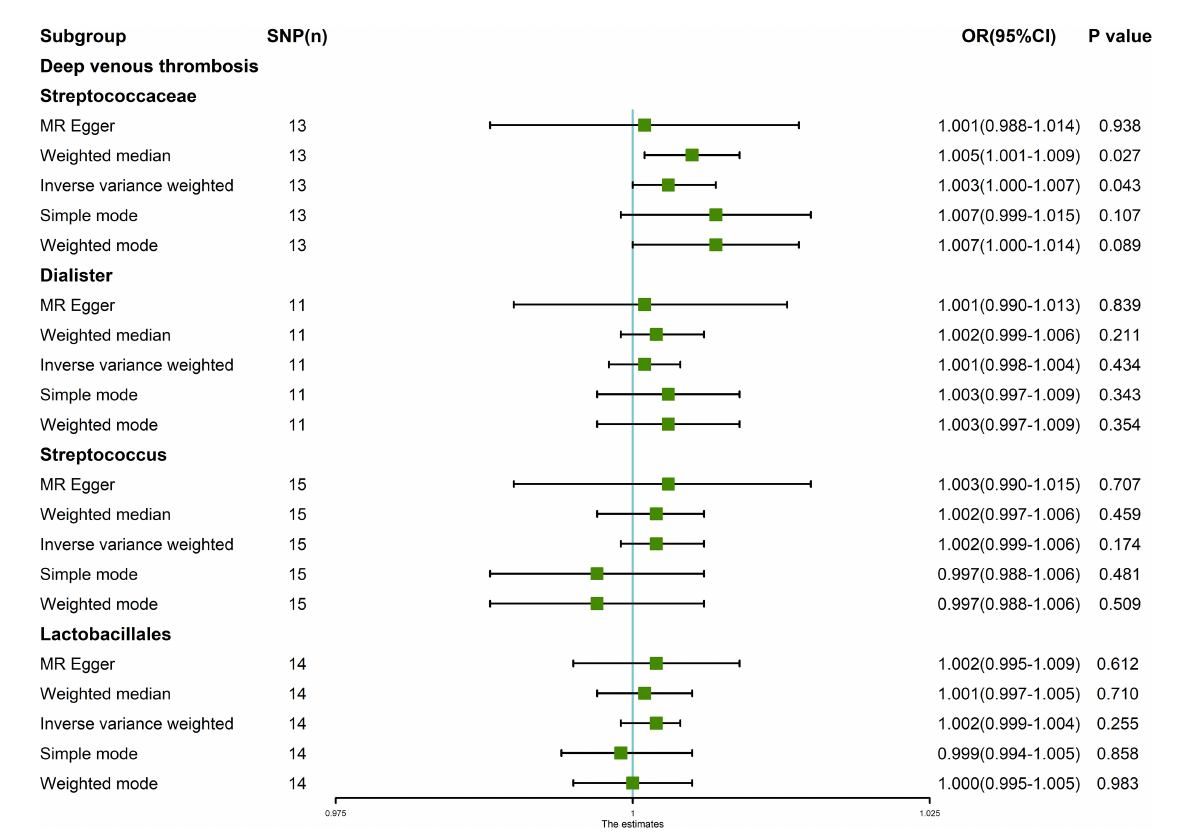
FIGURE2 Mendelian randomization (MR) analysis results of the exposures (Streptococcaceae, Dialister, Streptococcus, and Lactobacillales) and outcomes (deep venous thrombosis). Five methods: random-effects inverse variance weighted, MR egger, weighted median, simple mode, and weighted